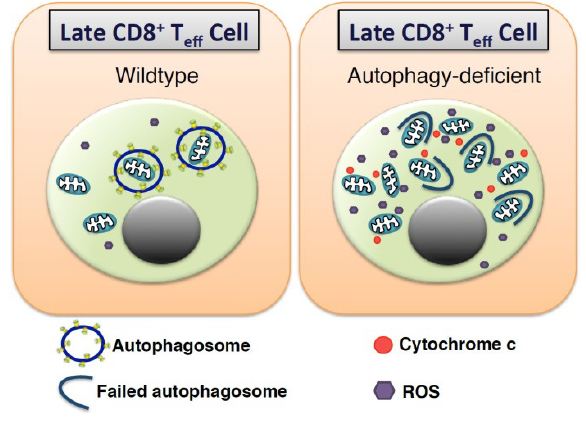
FIGURE 1: Autophagy acts as an antioxidant pathway in antigen- specific CD8 + T cells. During the effector phase in wild type mice, autophagy regulates mitochondrial load, acting to maintain orga- nelle quality and limiting ROS production. In the absence of au- tophagy, the mitochondrial burden of late effector CD8 + T cells (CD8 + T eff ) is increased, quality control is diminished, both of which contribute to excess ROS formation resulting in cell death.